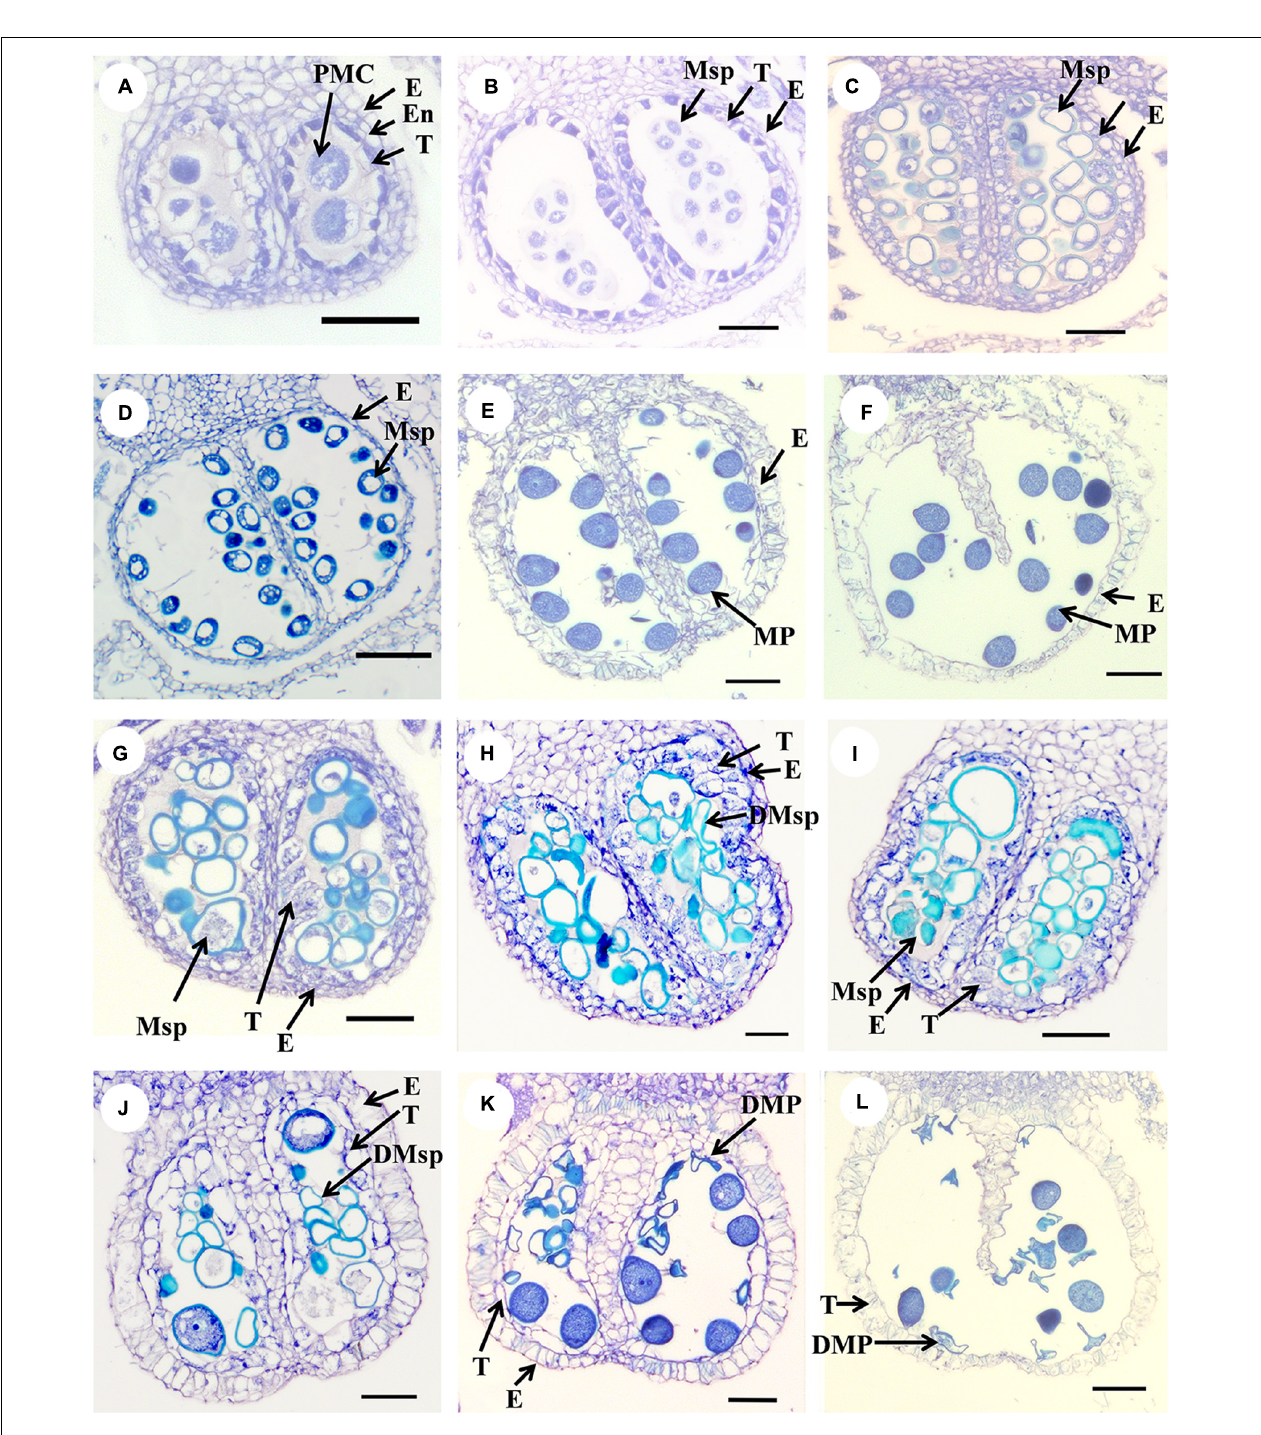
FIGURE 2 | The cross-section analysis of anther development in CK and HS. (A–F) Anther cross-sections of different developmental stages under CK, (A–B) meiosis stage, (C–D) microspore stage, (E–F) and mature stage. (G–L) Abnormal anther in HS. bar = 50 µ m.